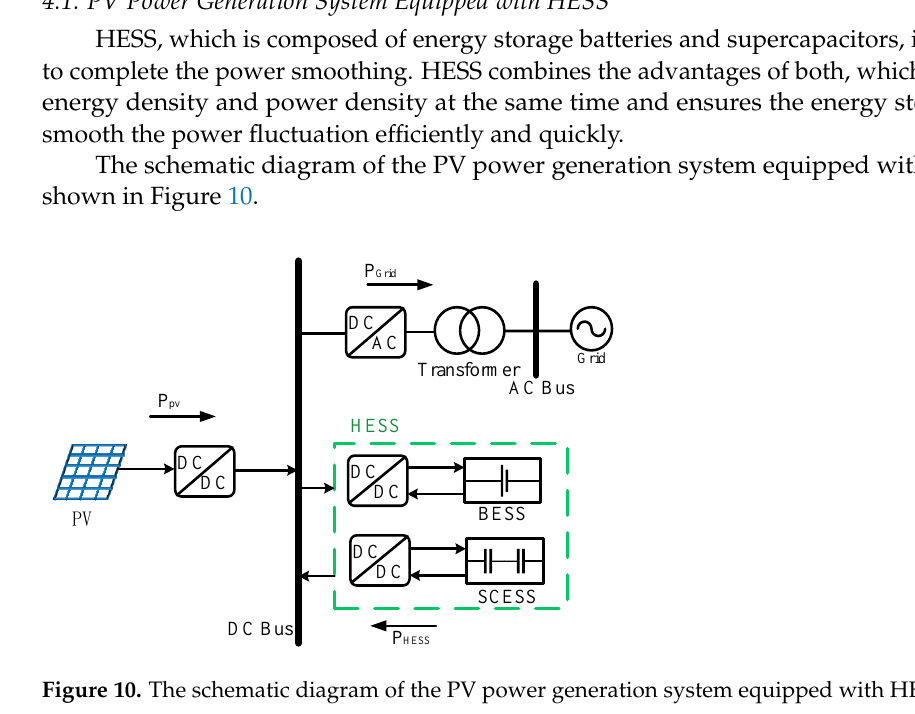
10 of 15 Figure 9. Fitting diagram of the optimized predicted power. The new power prediction fitting curve after translation and calculation is shown in Table 1. Table 1. Evaluation indicators table.